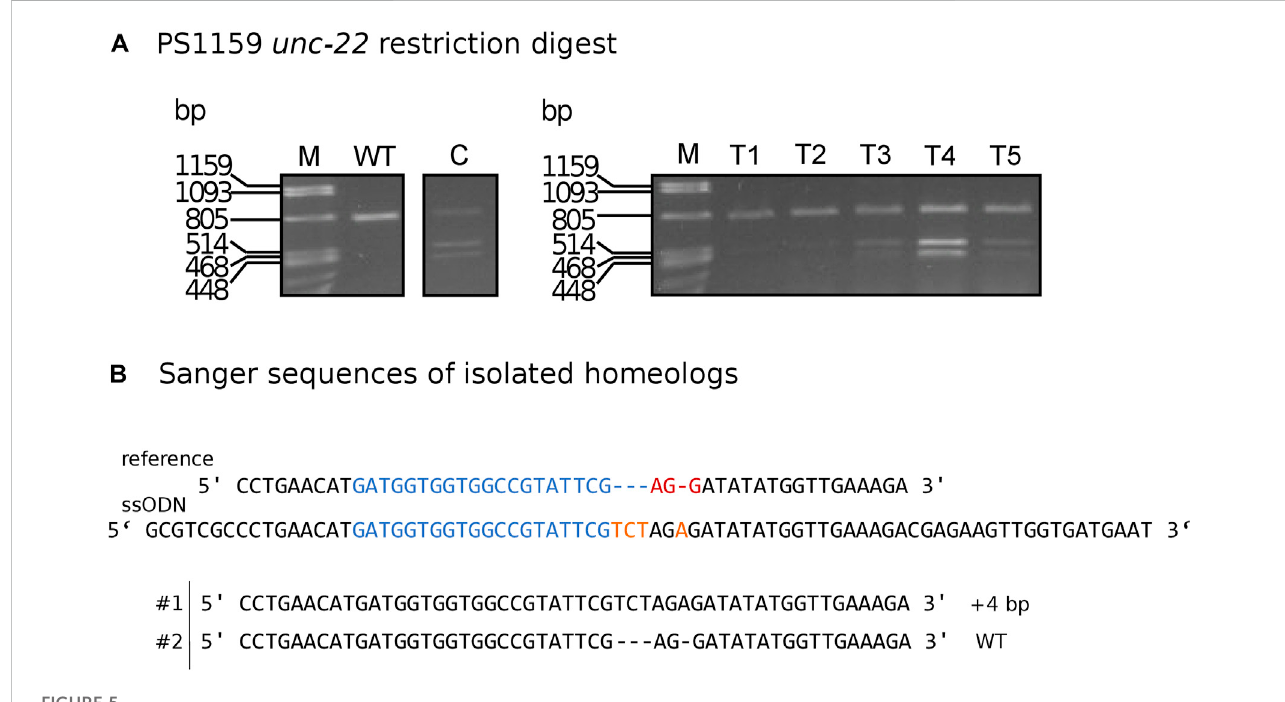
FIGURE 5 (A) Panagrolaimus sp.PS1159 unc-22 :Representativeexamplesofagarosegelelectrophoresisafterrestrictiondigestwith Xba Iofknock-inexperiments. Multiple band patterns of mutants with desired insertion. M = Marker Lambda Pst I digest. C = positive control of approved knock-in positive F1. T1 - T5 = twitchers 1-5. (B) Sanger sequencing revealing insertion in one homeolog (#1) after DNA cloning of mutant after positive restriction digest. Wild-type sequence in homeolog #2. Target region (blue) and PAM site (red). Xba I cleavage site in dark yellow.